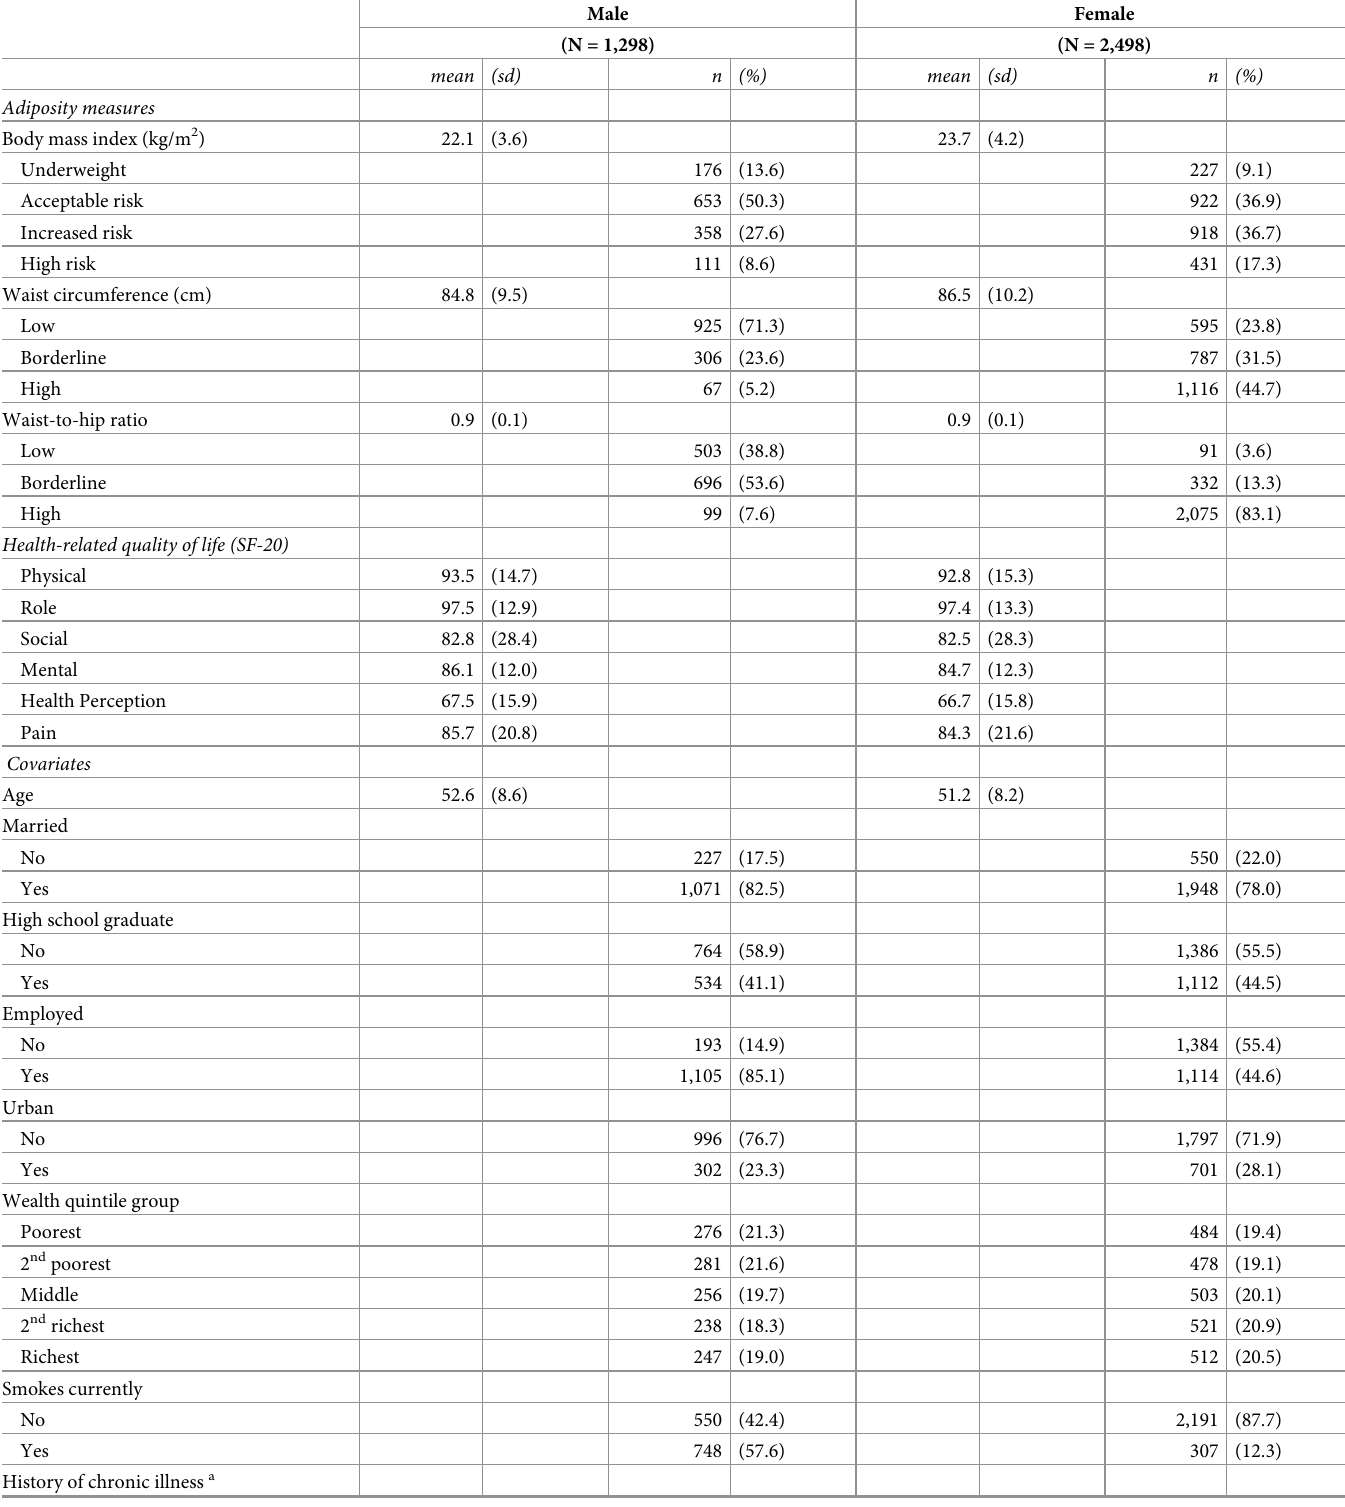
Table 1. Participant characteristics by